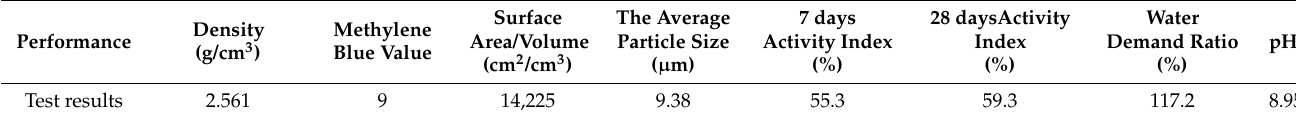
Table A7. Properties of WTSP.